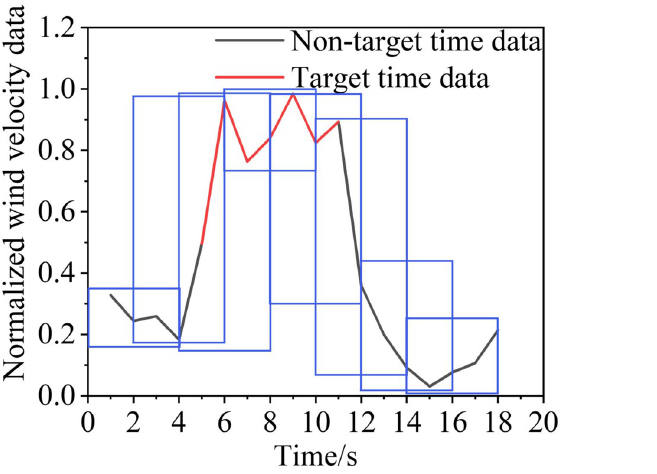
Fig 17. Sliding window discretized with 2 scalings.